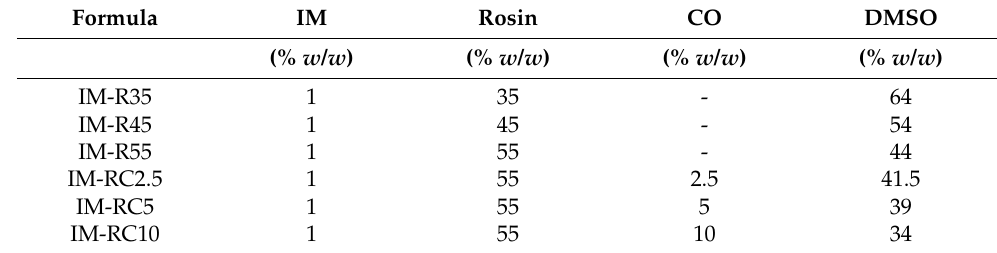
Table 3. Composition of the IM-loaded rosin/cinnamon oil-based ISG